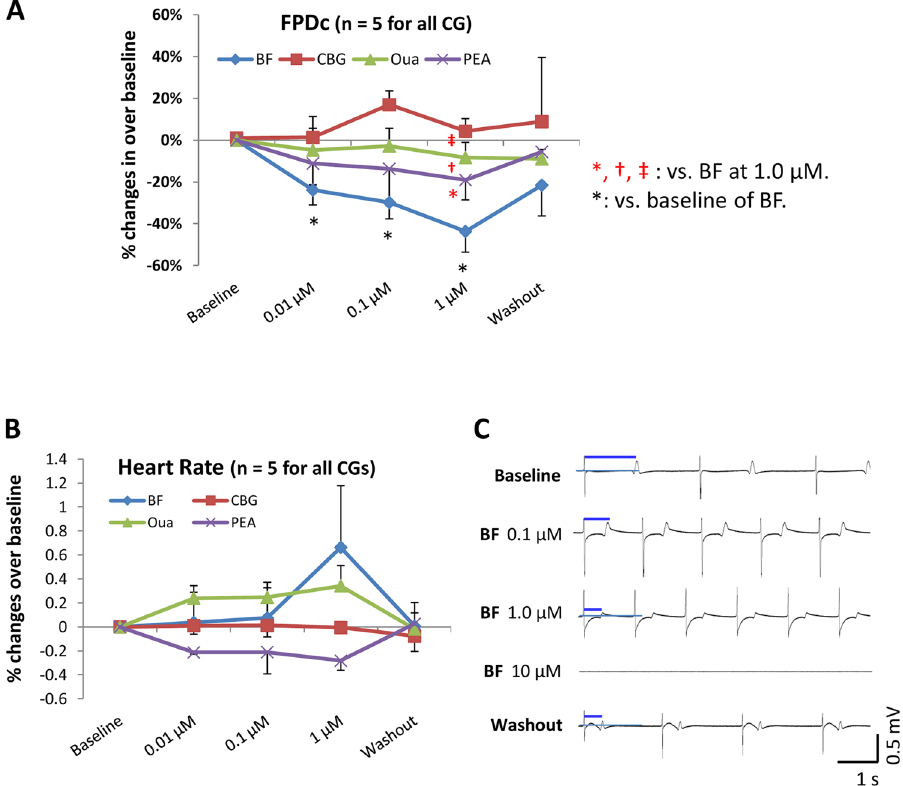
Figure 6. Effect of CGs on FPs in hESC-CMs. Effects of BF, CBG, Oua and PEA on cardiac FPs were recorded in clusters of hESC-CMs. ( A ) % changes of the FPDc over baseline. ( B ) % changes of the heart rate over baseline. ( C ) Representative FP traces show the effects of BF. All recordings were started after stabilization for 5 minutes. * p < 0.05, vs. baseline (One-Way ANOVA). * (red) p < 0.05, †(red) p < 0.01, ‡(red) p < 0.001, vs. BF (Two- Way ANOVA). Data are presented as mean ±